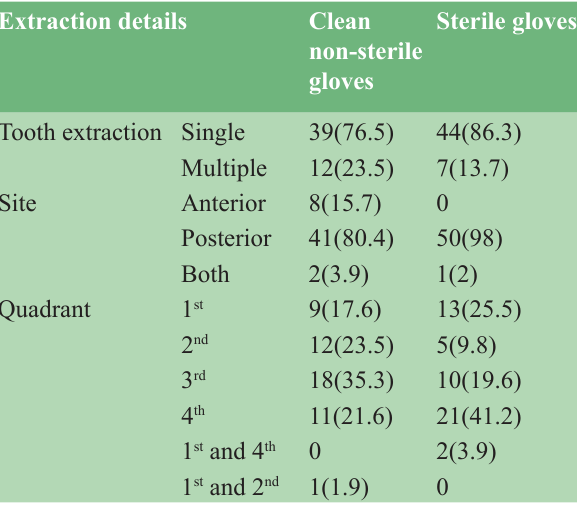
Table 1. Tooth extraction details in both group